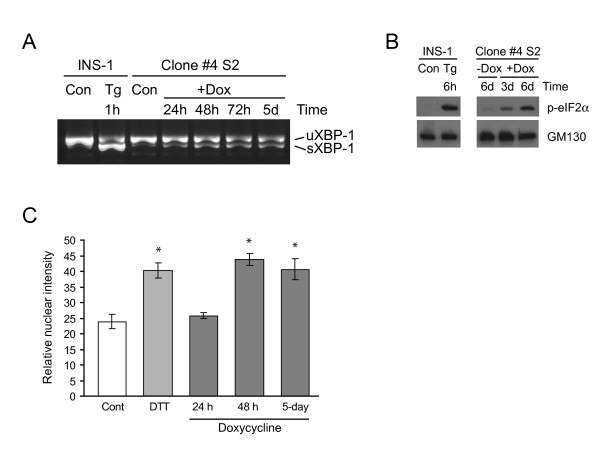
ER stress signaling pathways are activated by insulin 2 (C96Y)-EGFP expression. Clone #4S2 cells were untreated (-Dox) or treated with 2 μg/ml doxycycline (+Dox) for the times indicated. Control INS-1 cells exposed to thapsigargin (Tg) or dithiothreitol (DTT) were used as a positive control. A. RNA was isolated from the cells and XBP-1 cDNA was amplified by RT-PCR. The unspliced form of XBP-1 (uXBP-1, 480 bp) and spliced form of XBP-1 (sXBP-1, 454 bp) are indicated. B. Clone #4S2 cells were treated as in (A), washed in PBS and lysed. Equal amounts of protein were resolved by SDS-PAGE and immunoblotted with anti-phospho-eIF2α and GM130 antibodies. C. Clone #4S2 cells were treated with 1 mM dithiothreitol (DTT) for 30 min. or doxycycline as indicated and fixed for immunofluorescence labeling with anti-ATF6 antibody. Nuclear fluorescence of ATF6 was quantified as described in the methods.